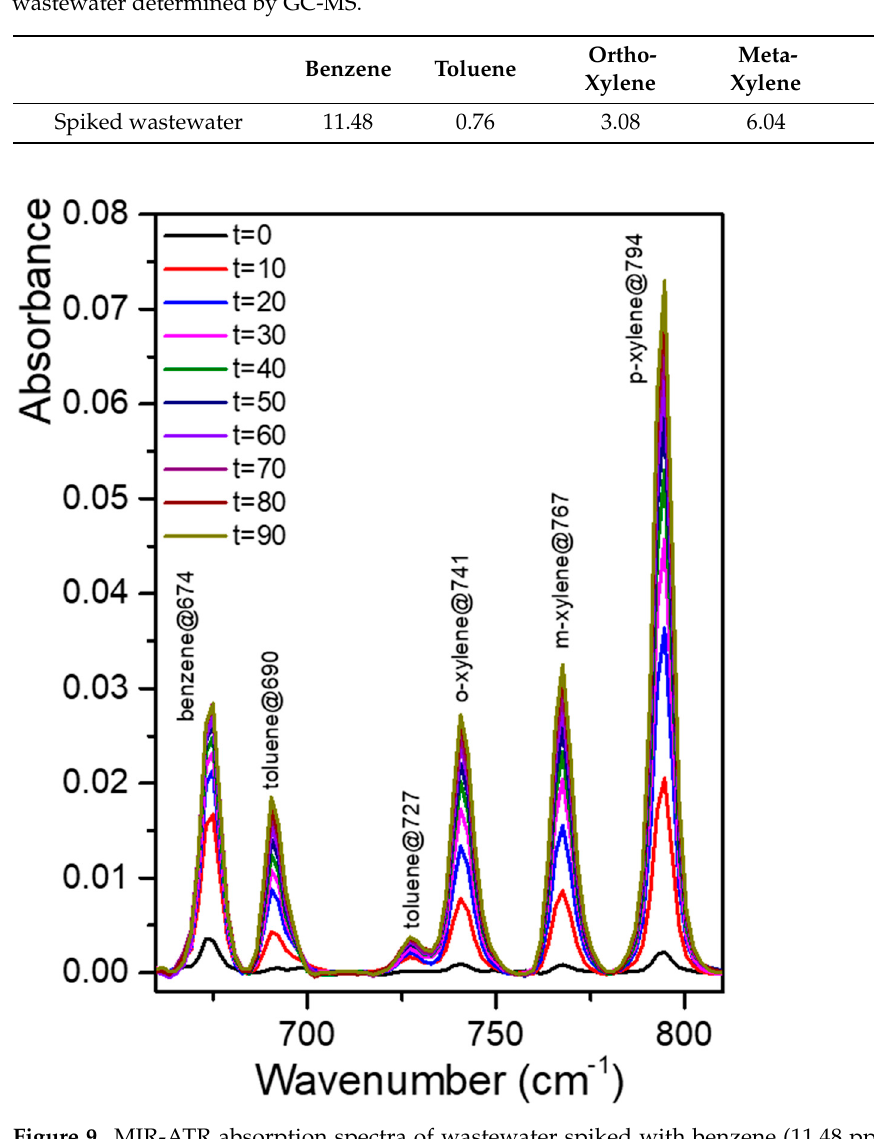
Figure 9. MIR-ATR absorption spectra of wastewater spiked with benzene (11.48 ppm), toluene (0.76 ppm), ortho-(3.08 ppm), meta-(6.04 ppm), and para-xylenes (11.88 ppm) for different time enrichment (from 0 to 90 min).